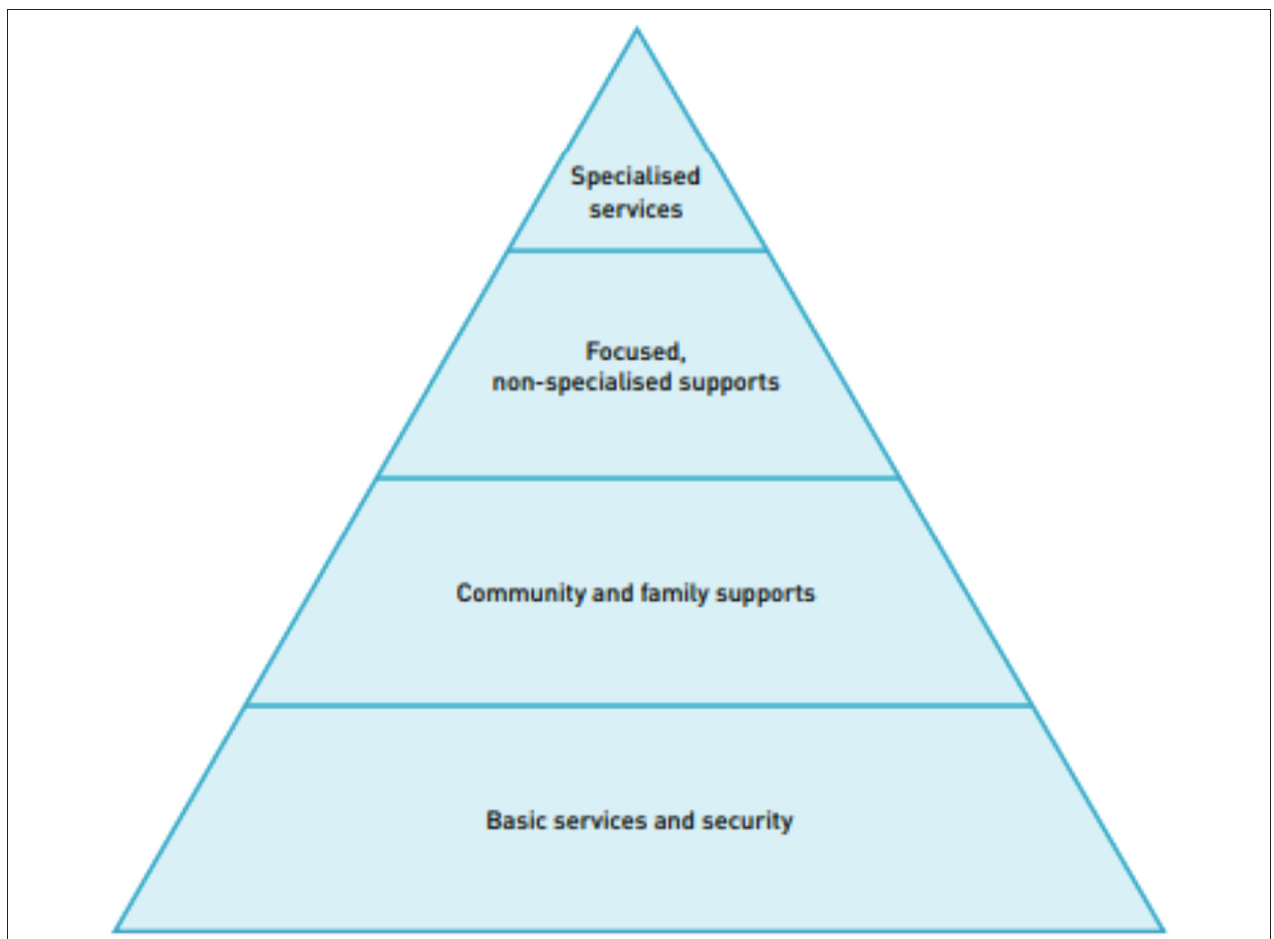
FIGURE 1 | Inter-Agency Standing Committee pyramid of mental health and psychosocial support